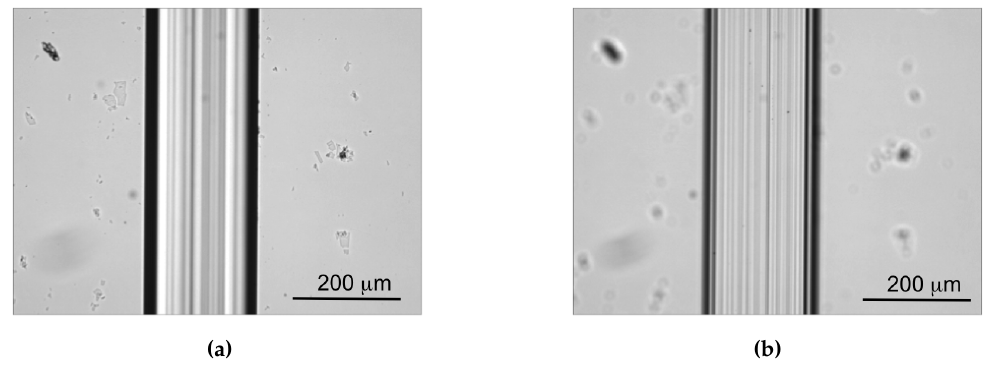
Figure 8. Micrographs of the upper edges ( a ) and the bottom surface ( b ) of the microfluidic channels obtained by mechanical micromachining with the dicing